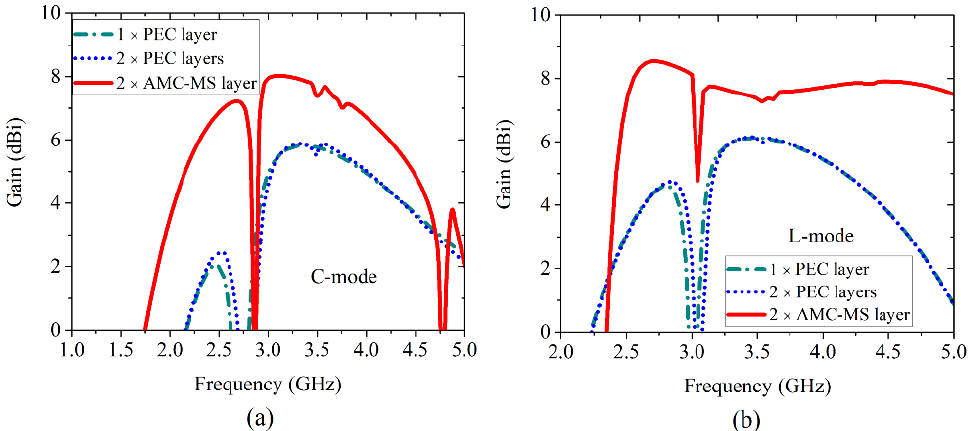
Figure 18. Comparison of simulated gain plots of the proposed antenna configuration: ( a ) C-mode and ( b ) L-mode, using PEC and AMC-MS reflectors.